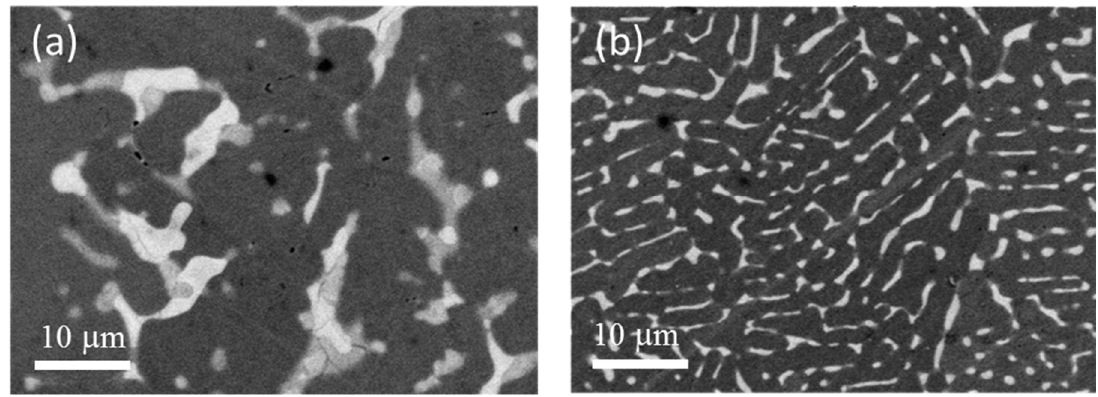
Figure 6. Secondary electron micrographs of ( a ) co ‐ melt and ( b ) single melt TiFe + 4 wt.% Zr alloys. Table 1. Bulk atomic abundance as measured by EDX of TiFe + 4 wt.% Zr single ‐ melt and co ‐ melt alloys. Error on each composition is indicated in parentheses.